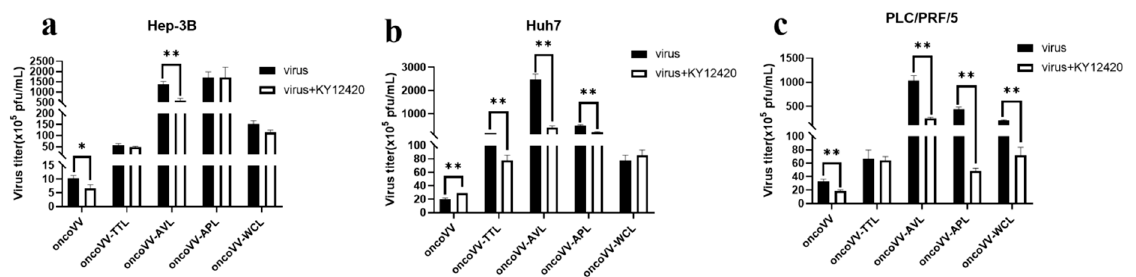
Figure 8. Virus yields in HCC treated with PI3K inhibitor. Hep-3B ( a ), Huh7 ( b ), and PLC/PRF/5 ( c ) cells were treated with combinations of oncoVV-lectins and KY12420 (4.5 μ mol/L) at 5 MOI for 36 h. OncoVV served as a control (* p < 0.05, ** p <